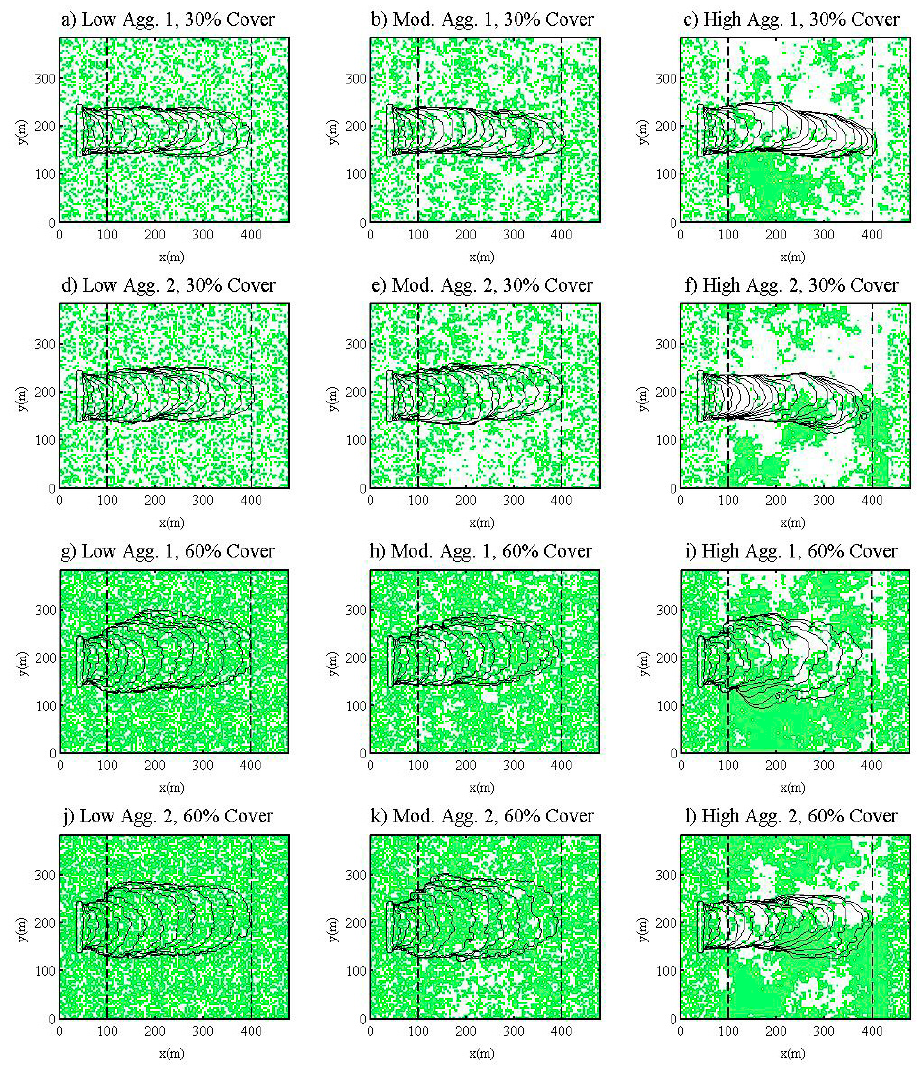
Figure 3. Maps of coupled fuel spatial patterns, with forest/litter in green and grass as white, overlaid with contours indicating progression of fires over time with moderate winds (6 m s − 1 10 m open wind speed). Fuel maps span three levels of aggregation (low, left, to high, right), and two levels of canopy cover (upper two rows: 30%; lower two rows: 60%).